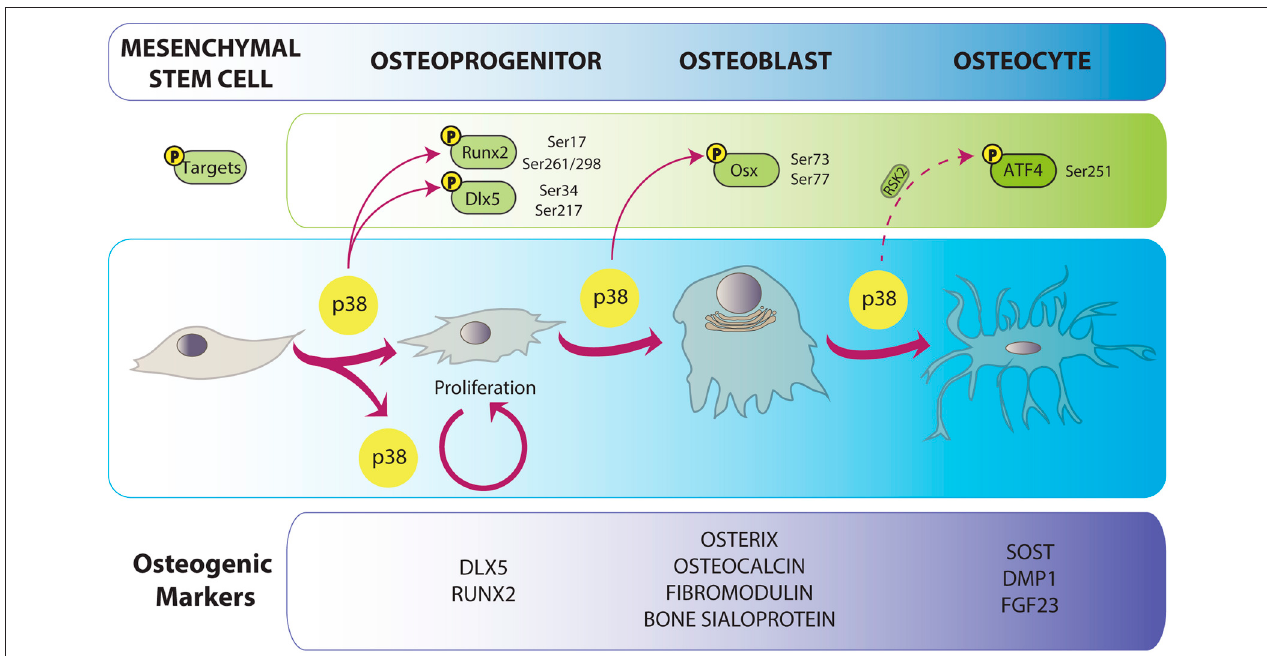
FIGURE 1 | p38 implication in osteoblast differentiation. Osteoblast differentiation is characterized by the expression of a specific cohort of proteins depicted in the lower panel. p38 is related both to differentiation and proliferation of bone progenitors. p38-mediated phosphorylation promotes progression in osteogenesis by the enhancement of the activity or expression of osteoblast-specific transcription factors genes. Direct arrows indicate direct phosphorylation while dashed arrow indicates indirect action of p38. Phosphorylated residues are specified for every